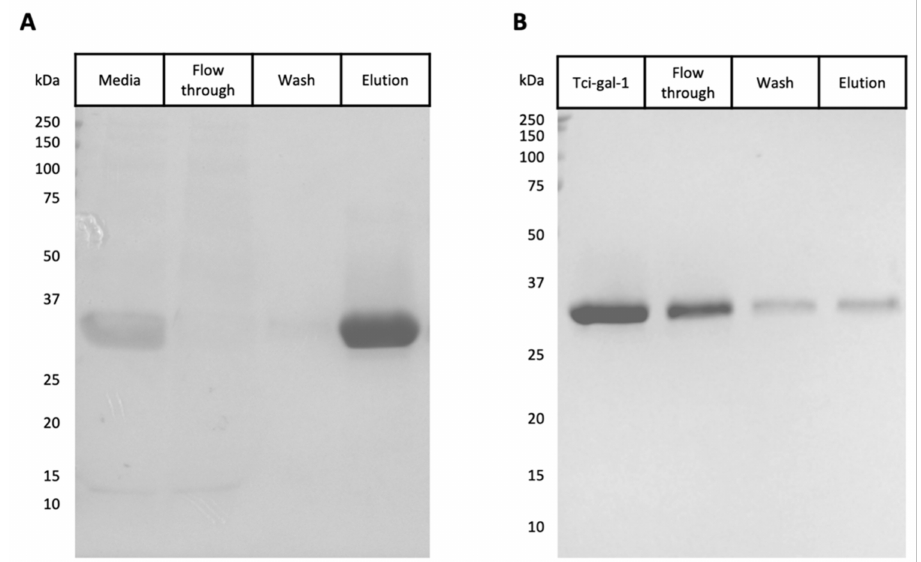
Figure 1. Purification and characterisation of Teladorsagia circumcincta galectin (Tci-gal-1) . ( A ) Pichia pastoris media expressing Tci-gal-1 were applied to a NI-IDA column and washed once before elution with imidazole. A total of 15 µ L of each stage of the purification was resolved by SDS-PAGE and stained with Coomassie blue. ( B ) Purified recombinant Tci-gal-1 was shown to be functional by elution from a lactose-Sepharose column with lactose. Equal volumes (15 µ L) of each sample were analyzed by SDS-PAGE and visualised with Coomassie blue